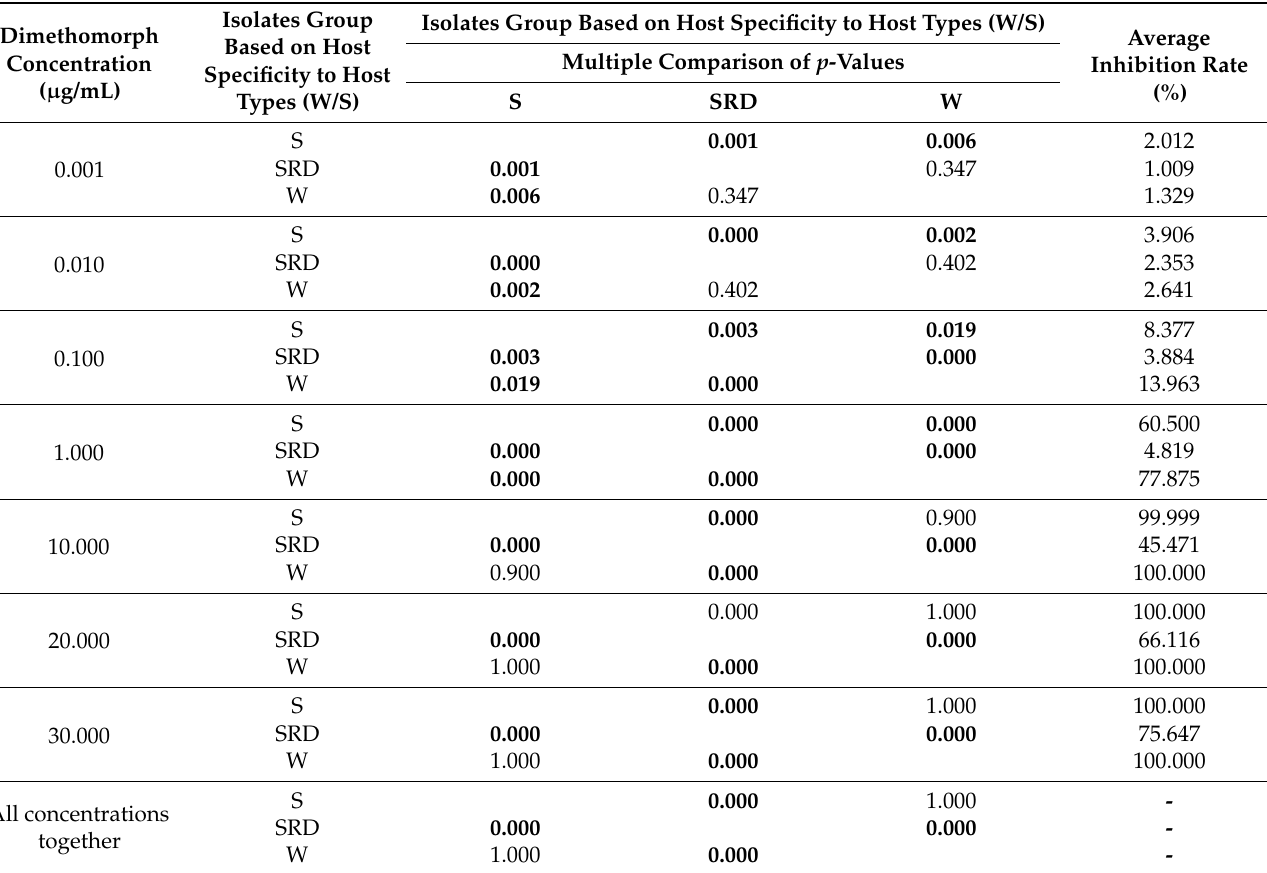
Table 6. Results of a multiple comparison of p -values of the Kruskal–Wallis test of P. cactorum growth inhibition caused by